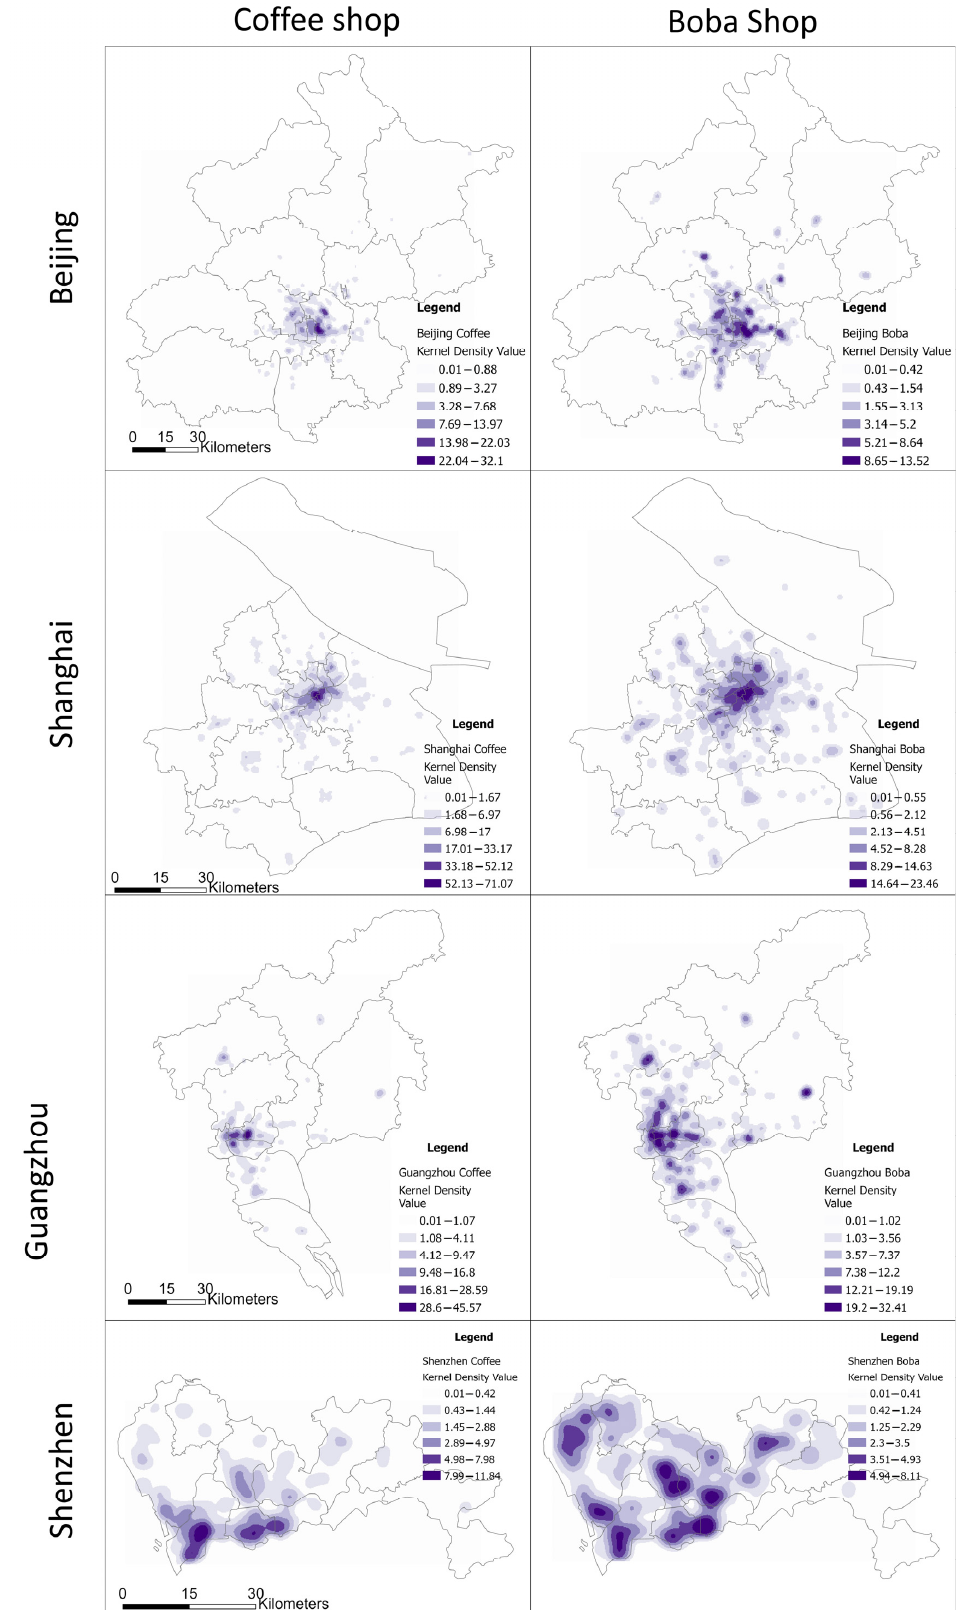
Figure 7. Kernel density maps of coffee and boba shops in 2022 in Beijing, Shanghai, Guangzhou, and Shenzhen (from top to